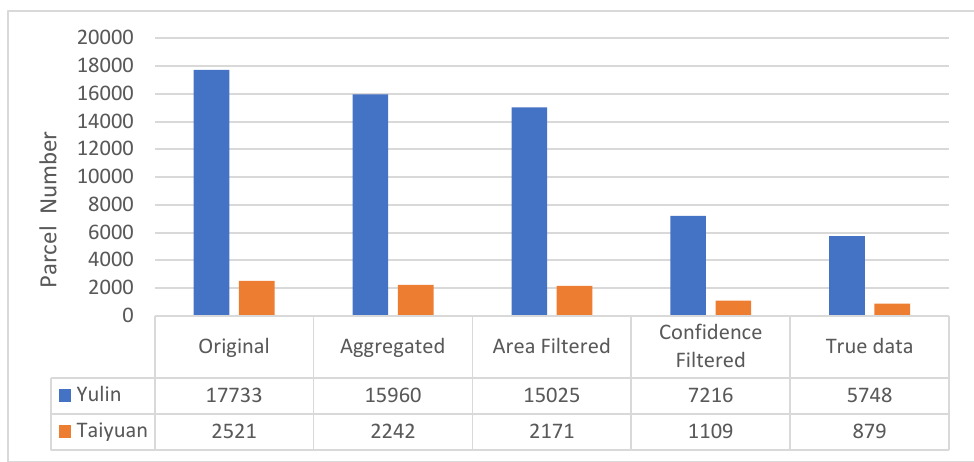
Figure 12. The number of parcels in each process.